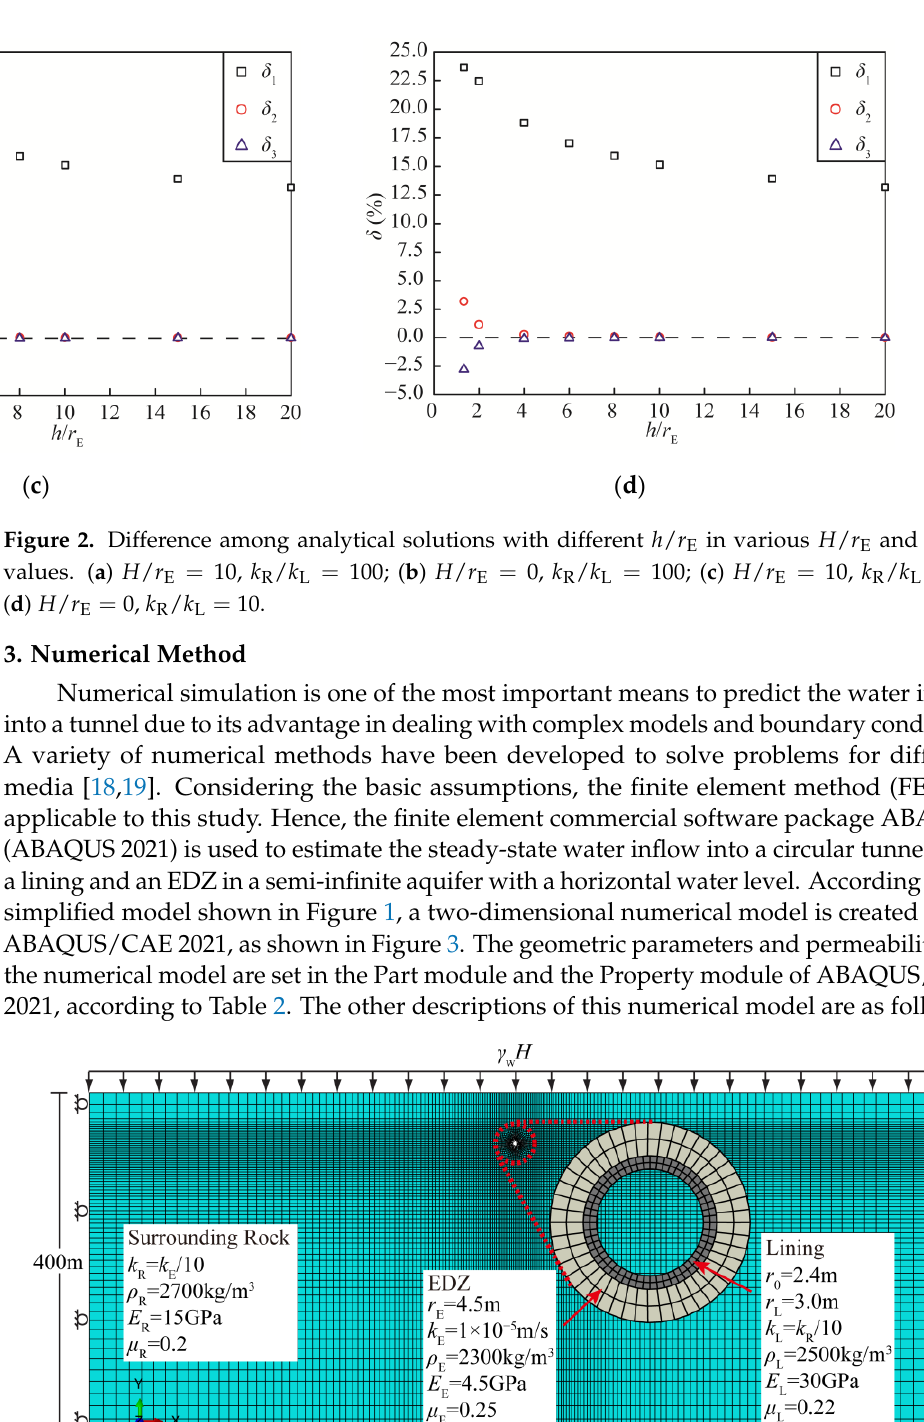
Figure 3. Numerical model for steady-state water inflow into a circular underwater tunnel with lining and an EDZ in a semi-infinite aquifer with a horizontal water level.